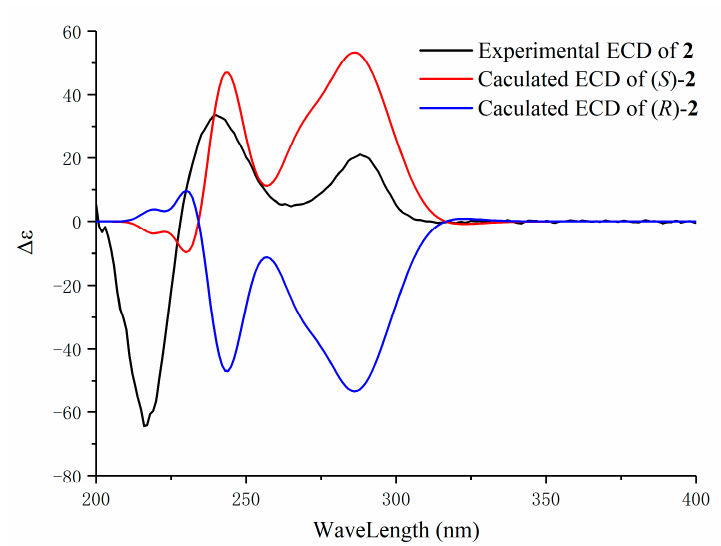
Figure 3. Experimental and calculated ECD spectra of compound 2 .